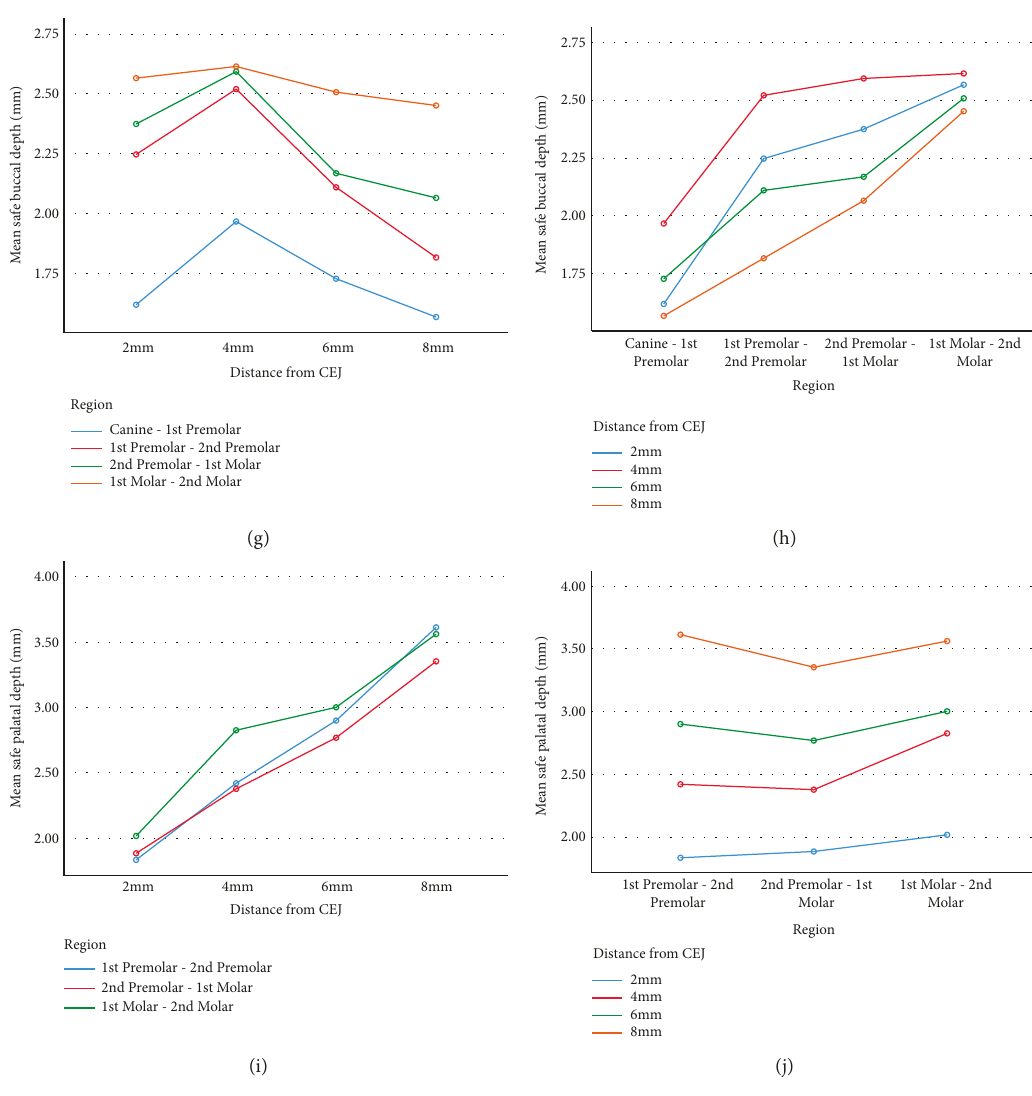
Figure 3: Graphs indicating mean distance between buccal and palatal roots based on region (a and d) and distance from CEJ (b and c). Mean buccal bone thickness based on distance from CEJ (e) and region (f). Mean buccal and palatal safe depth based on distance from CEJ (g and i) and region (h and j). Table 1: Distance between buccal and palatal roots in posterior maxilla in